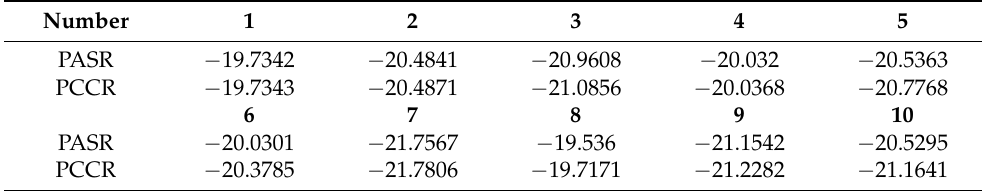
Table 4. OFDM-NLFM waveform set design results when the segmentation parameters set